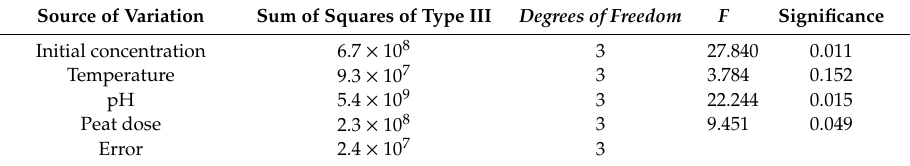
Table 5. Variance analysis of orthogonal experimental